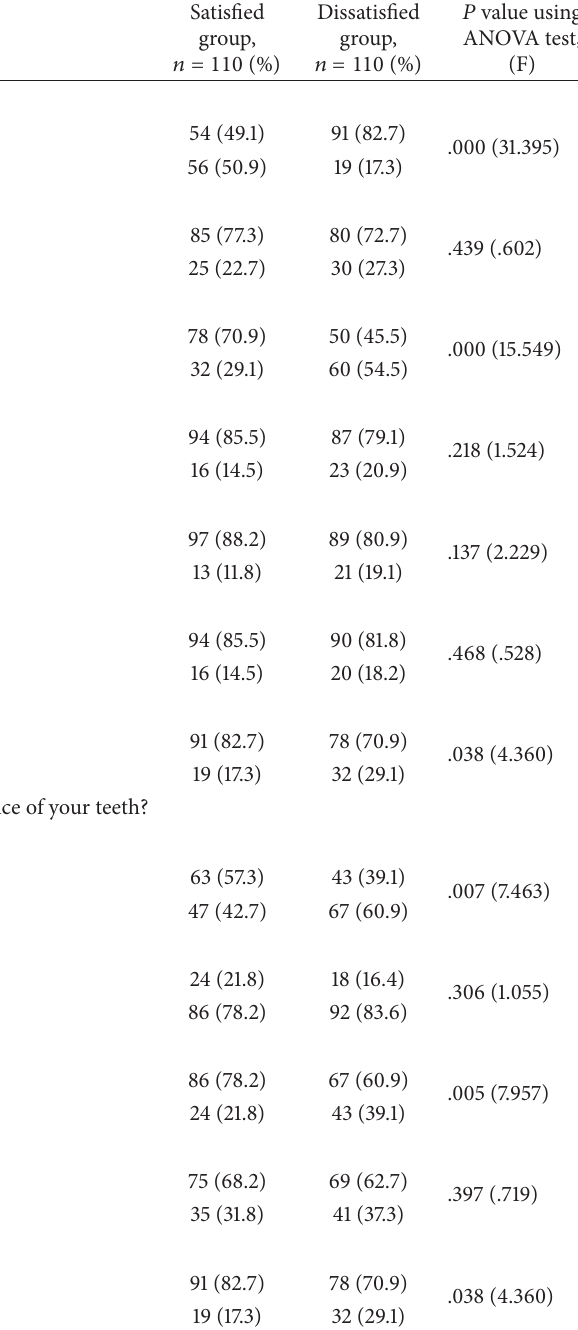
Table 5: Distribution of satisfied ( 𝑛 = 110 ) and dissatisfied ( 𝑛 = 110 ) participants by mean VAS score of satisfaction, answers to the questionnaire items, and their socio-demographic